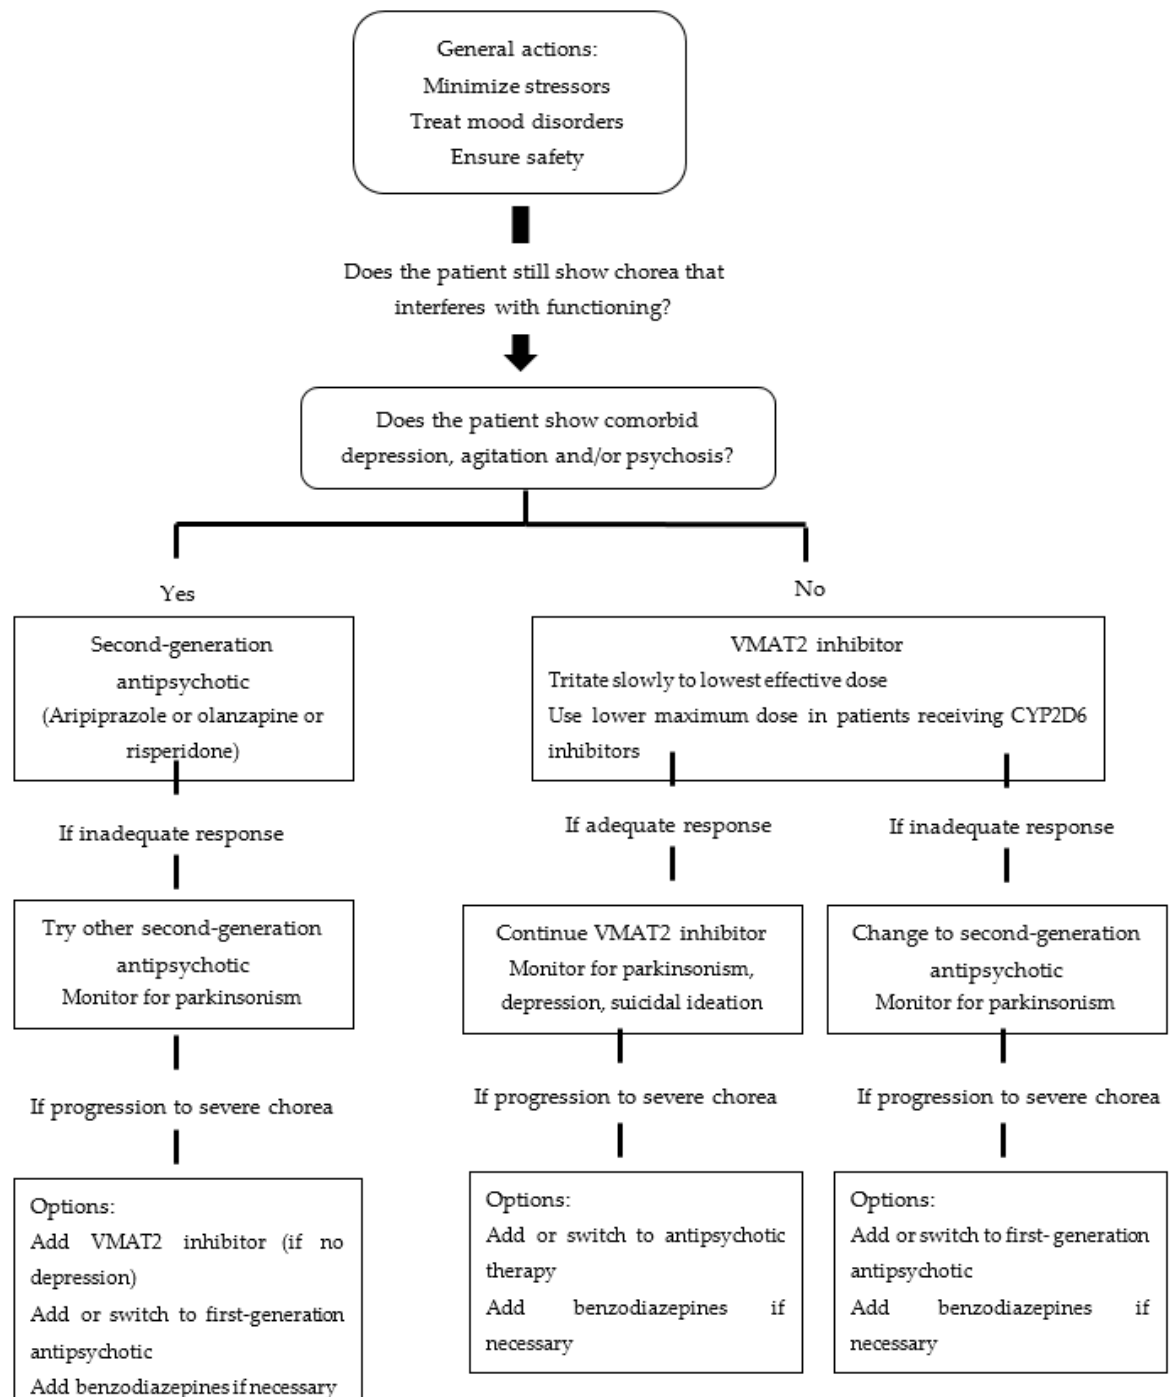
Figure 1. Treatment algorithm for chorea in HD, adapted from Suchowersky et al.’s Huntington Disease: Management [13].